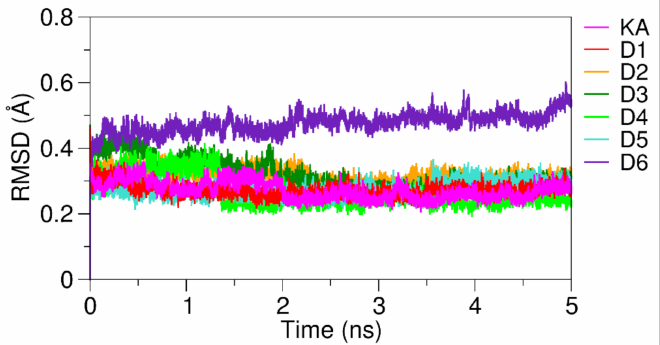
Figure 5. RMSD plots of the tyrosinase structure complexed with KA and its derivatives.